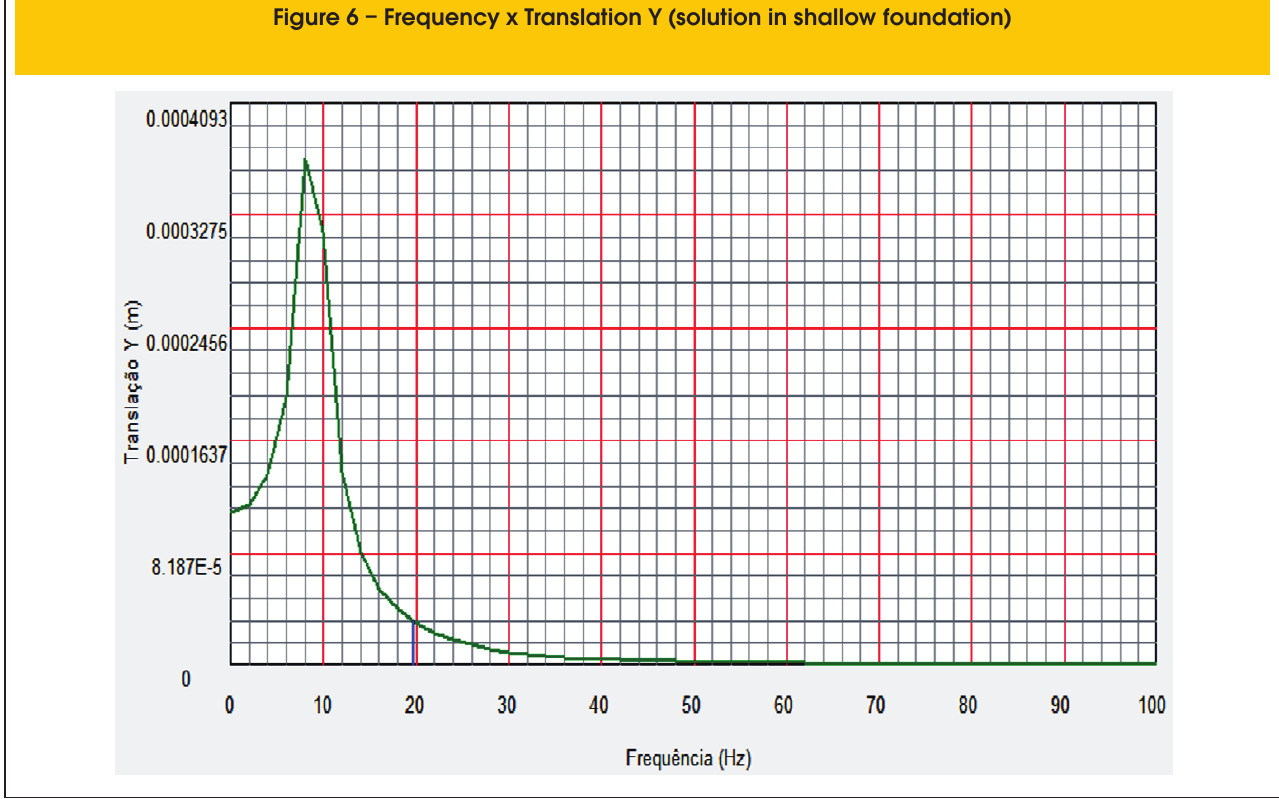
Figure 6 – Frequency x Translation Y (solution in shallow